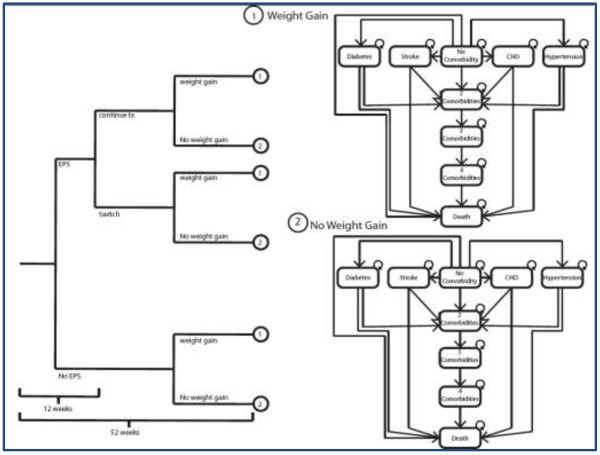
Model structure.